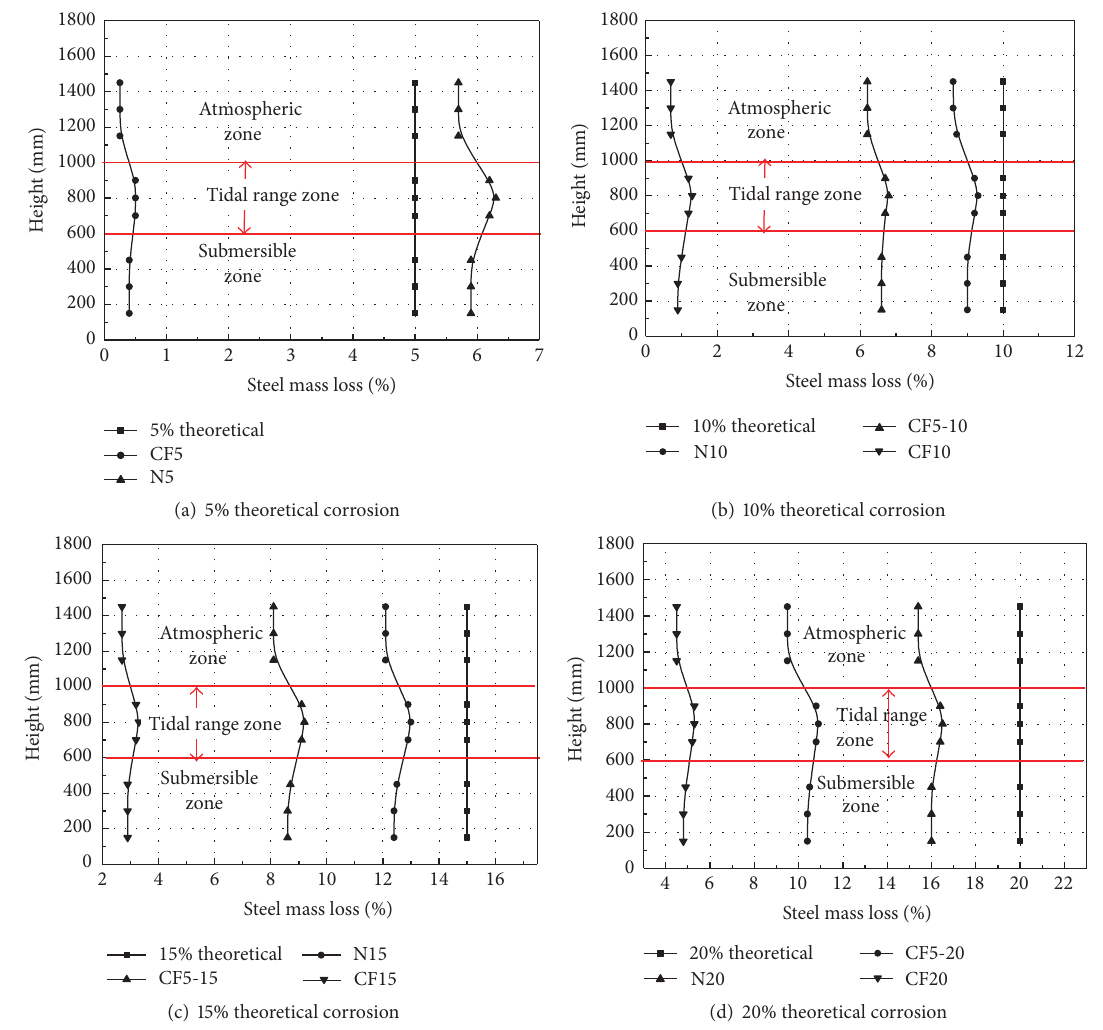
Figure 7: Theoretical and measured steel mass loss.